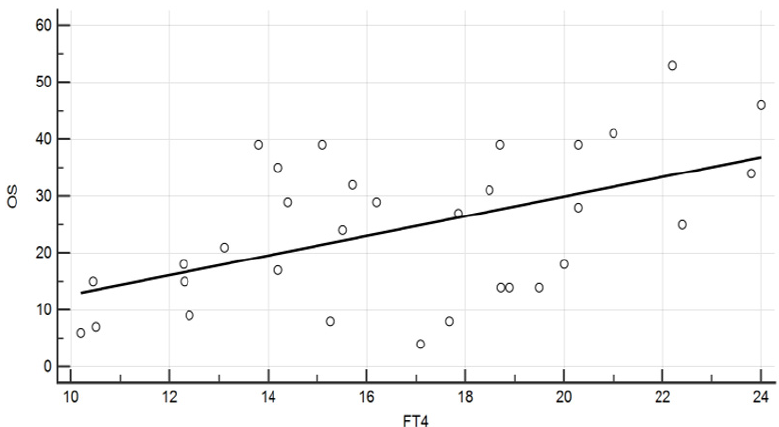
Figure 1. Diagram showing the association between fT4 levels (pg/mL) and the overall survival